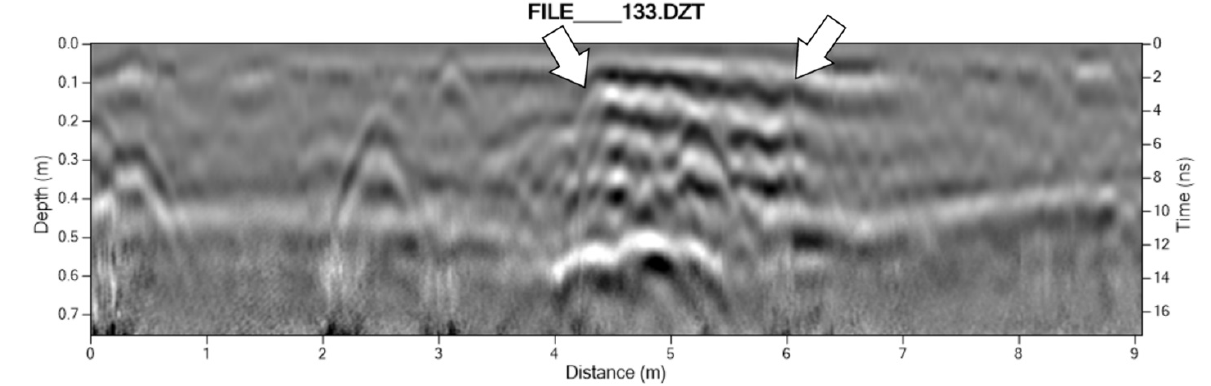
Figure 19. Oblique transect crossing San Juan Bautista Building B wall.